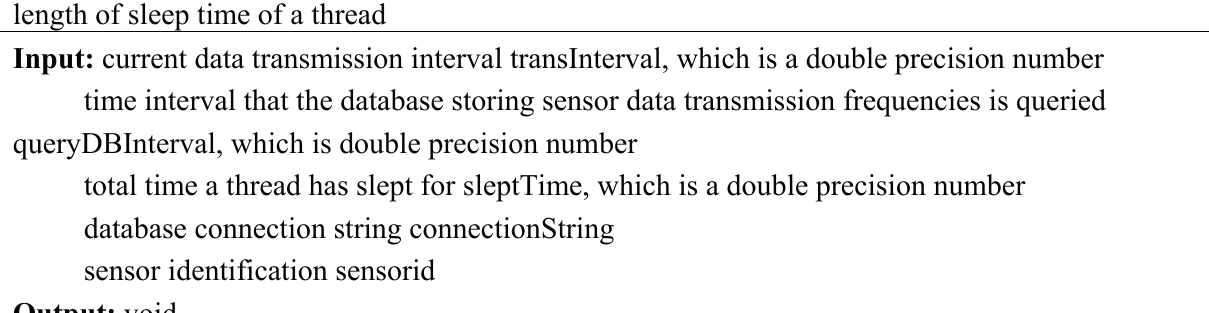
Algorithm 2 Adjust thread sleep time (ATST) algorithm, which is used to dynamically change the length of sleep time of a